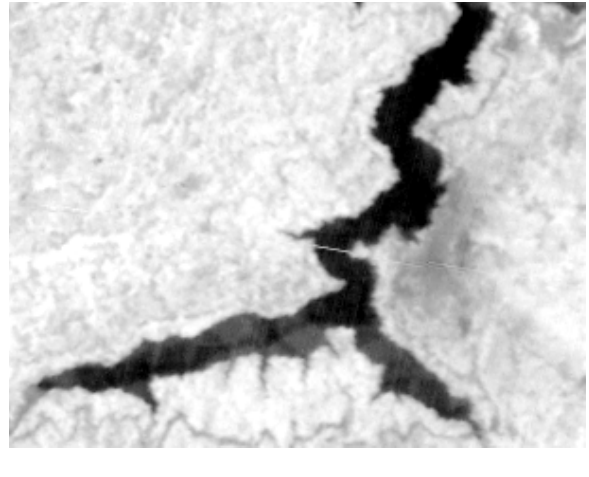
Figure 14. Slope